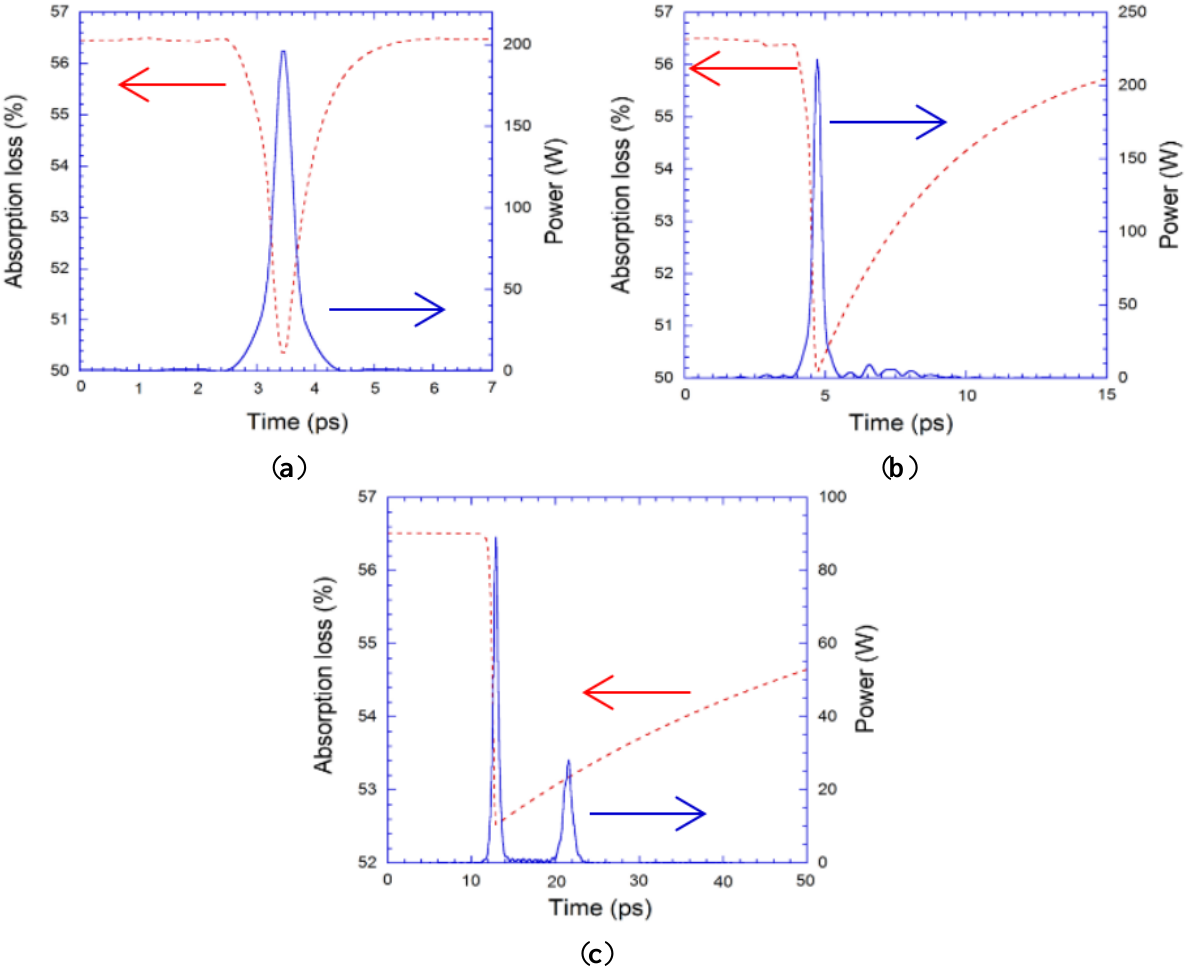
Figure 14. Temporal shapes of mode-locked pulse and variation of absorption loss at SWNT film for recovery times of ( a ) 0.7 ps; ( b ) 7 ps; and ( c ) 70 ps in soliton mode-locking